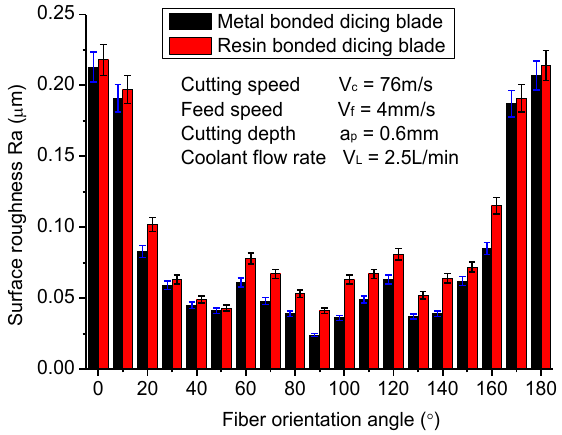
Figure 11. Surface roughness varying with fiber orientation.